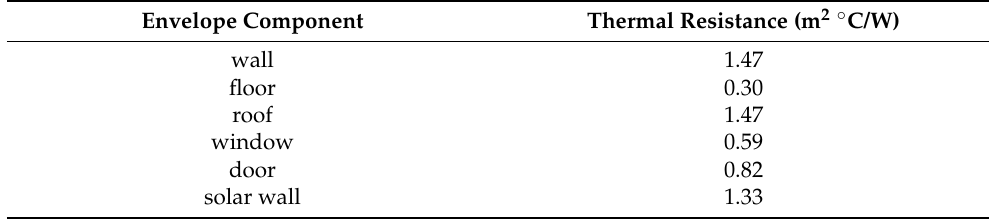
Table 6. Thermal resistance — container envelope components.